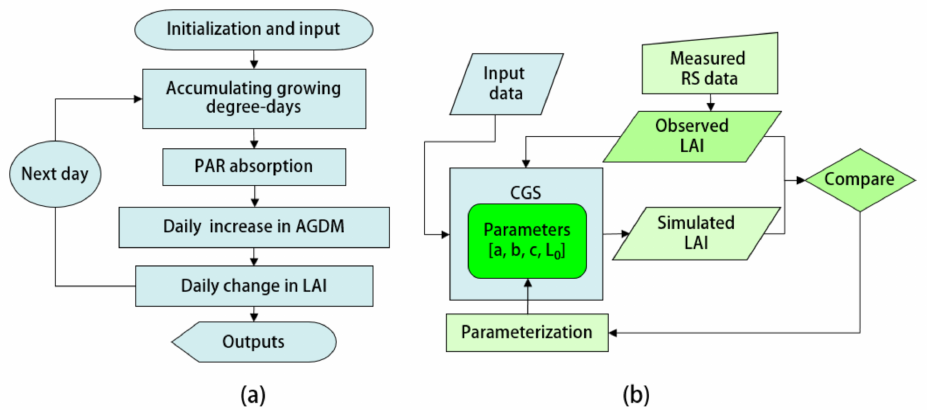
Figure 2. Diagrammatic representation of the remote sensing-integrated crop model (RSCM) for cotton: ( a ) cotton growth simulation (CGS) procedure and ( b ) optimization of model parameters using proximal or remote sensing information. AGDM, LAI, PAR, and RS represent above-ground dry mass, leaf area index, photosynthetically active radiation, and remote sensing,